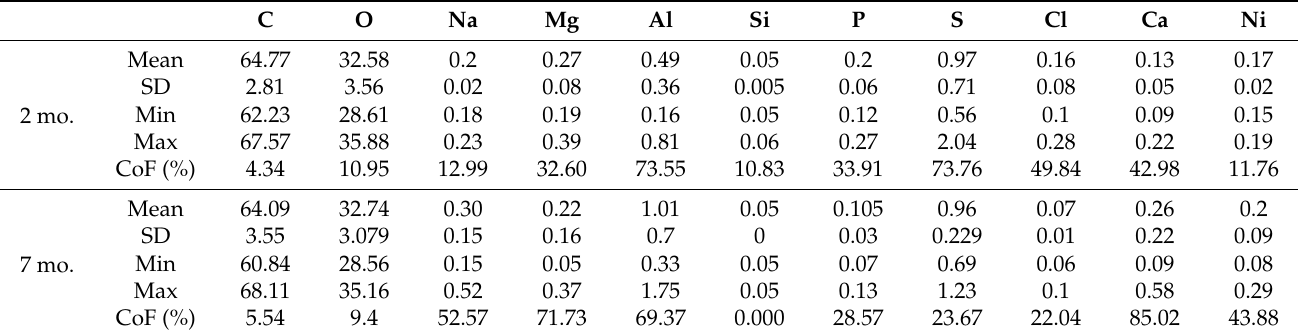
Table 1. Elemental composition (weight percent) of the lens of male N. guentheri aged two and seven months.